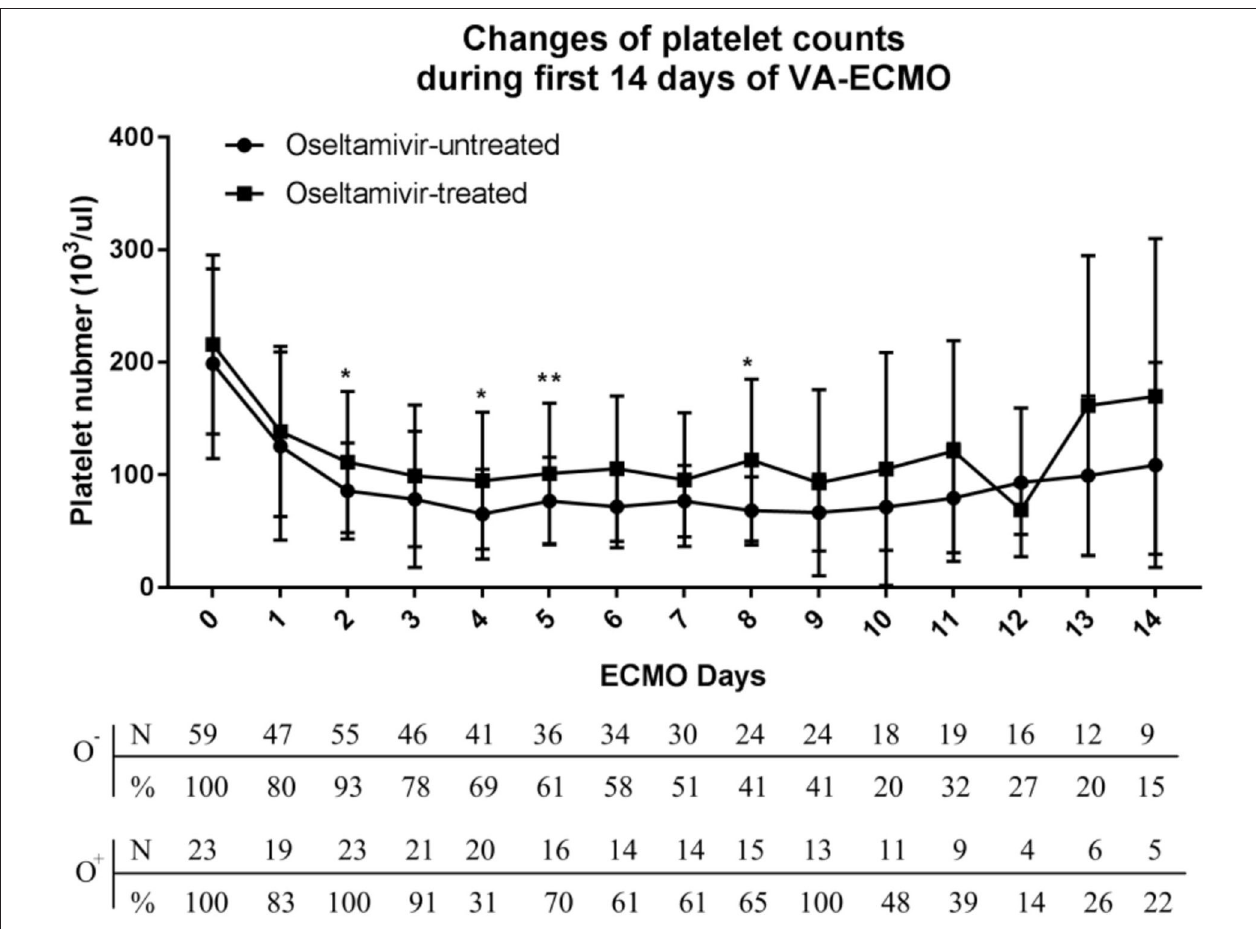
FIGURE 2 | Variation of platelet counts in the oseltamivir-treated and oseltamivir–untreated groups during the first 14 days of veno-arterial extracorporeal membrane oxygenation (VA-ECMO)